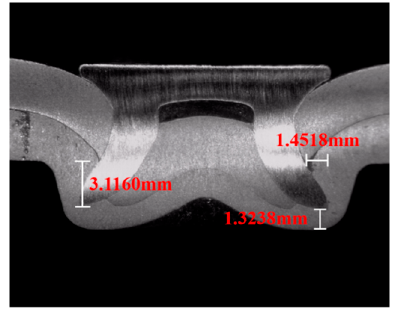
Figure 2. Cross-section and characteristic dimensions.